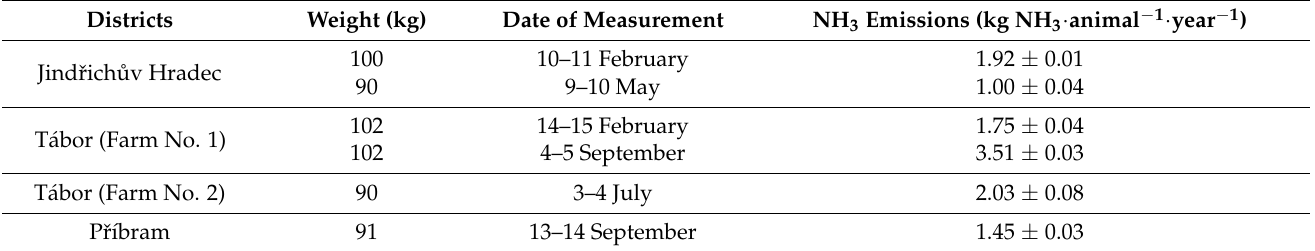
Table 5. Results of the calculated NH 3 emission from the first approach monitoring.